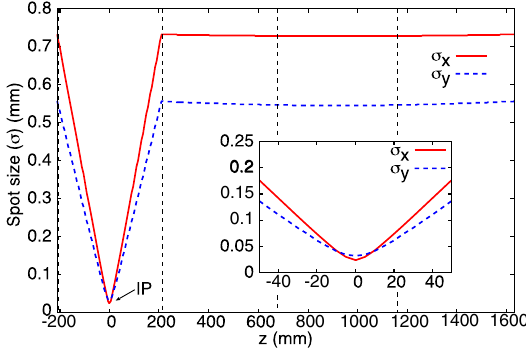
FIG. 10. Spot size of laser beam along the propagation in the cavity. Vertical dotted lines show the position of the mirrors.